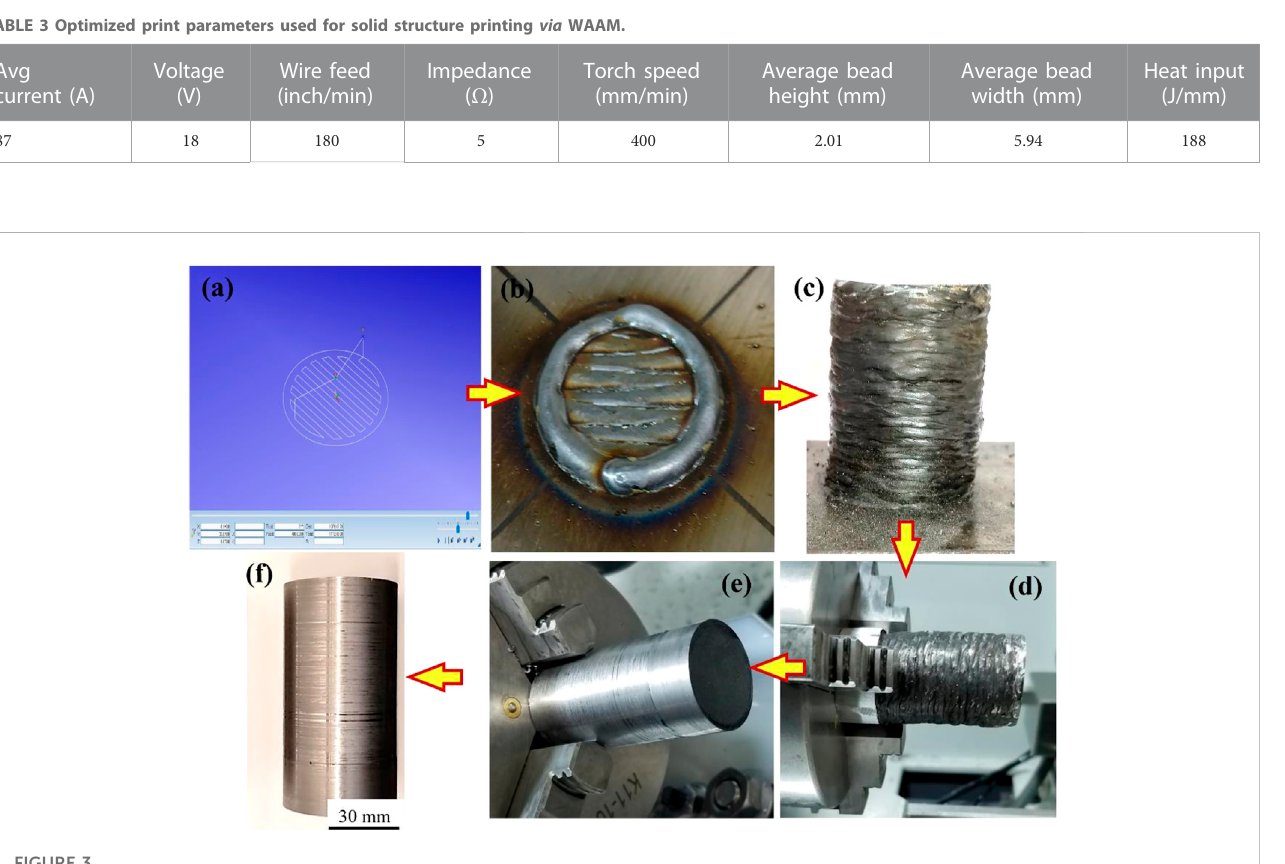
Frontiers in Mechanical